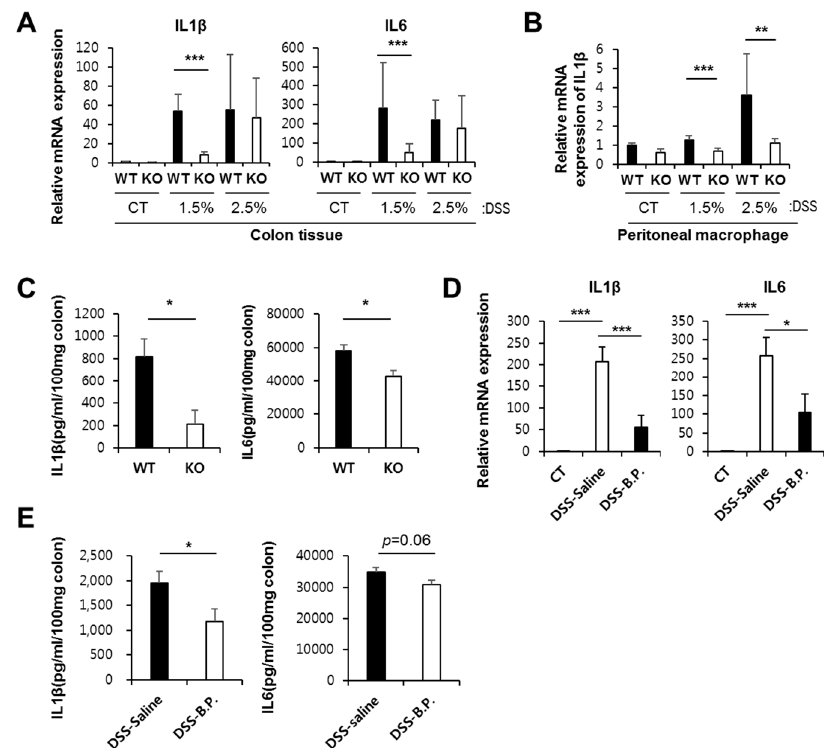
Figure 5. Loss of Ninj1 from macrophages reduces the production of cytokines. ( A ) Relative mRNA expressions of IL1 β and IL6 were analyzed by performing qRT-PCR using colon tissues from untreated and DSS-treated WT and Ninj1 KO mice; n = 3 per group. The expression values are normalized to GAPDH, and the plots are presented as mean ± SEM. *** p < 0.005, Student’s t -test. Similar results were observed in three independent experiments. ( B ) Relative mRNA expression of IL1 β was analyzed by performing qRT-PCR using peritoneal macrophages from untreated and DSS-treated WT and Ninj1 KO mice; n = 3 per group. Data are presented as mean ± SEM. ** p < 0.01, *** p < 0.005, Student’s t -test. ( C ) WT and Ninj1 KO mice were treated with 1.5% DSS for 8 days. Mice were sacrificed on day 8 after initiating DSS treatment. Colonic tissue explants were harvested, and secreted IL1 β and IL6 levels were assessed by ELISA; n = 4 per group. Data are presented as mean ± SEM. * p < 0.05, Student’s t -test. Similar results were observed in three independent experiments. ( D ) WT mice